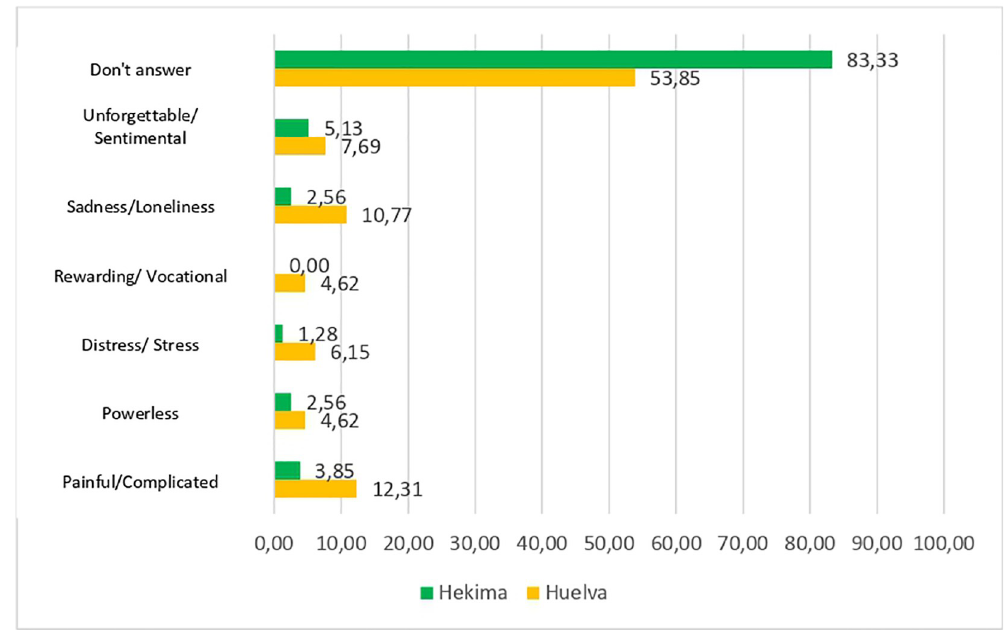
Fig 1. Definition of the conception of death. Source: developed by the study